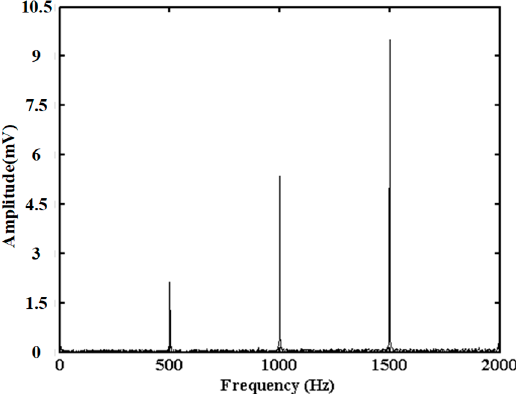
Figure 10. Frequency spectrum of amplitude curve after envelope demodulation algorithm.